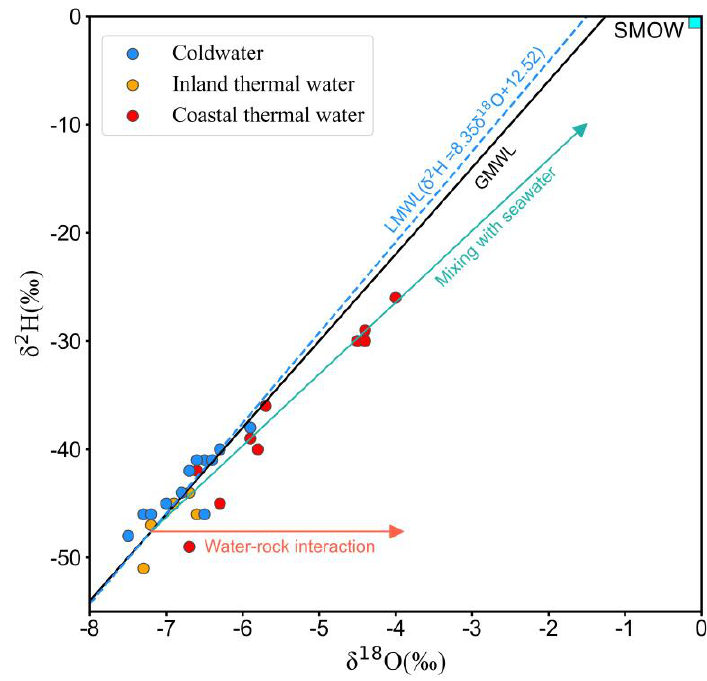
Figure 3. δ 2 H –δ 18 O relationships of water samples in southeastern China. Figure 3. δ 2 H– δ 18 O relationships of water samples in southeastern